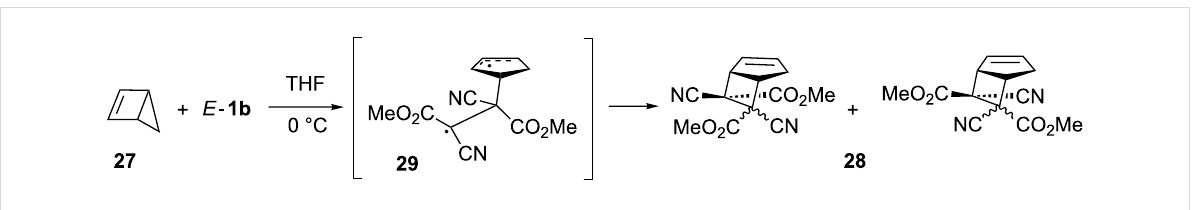
Scheme 8: Non-concerted [2 + 2]-cycloaddition between E - 1b and bicyclo[2.1.0]pentene ( 27